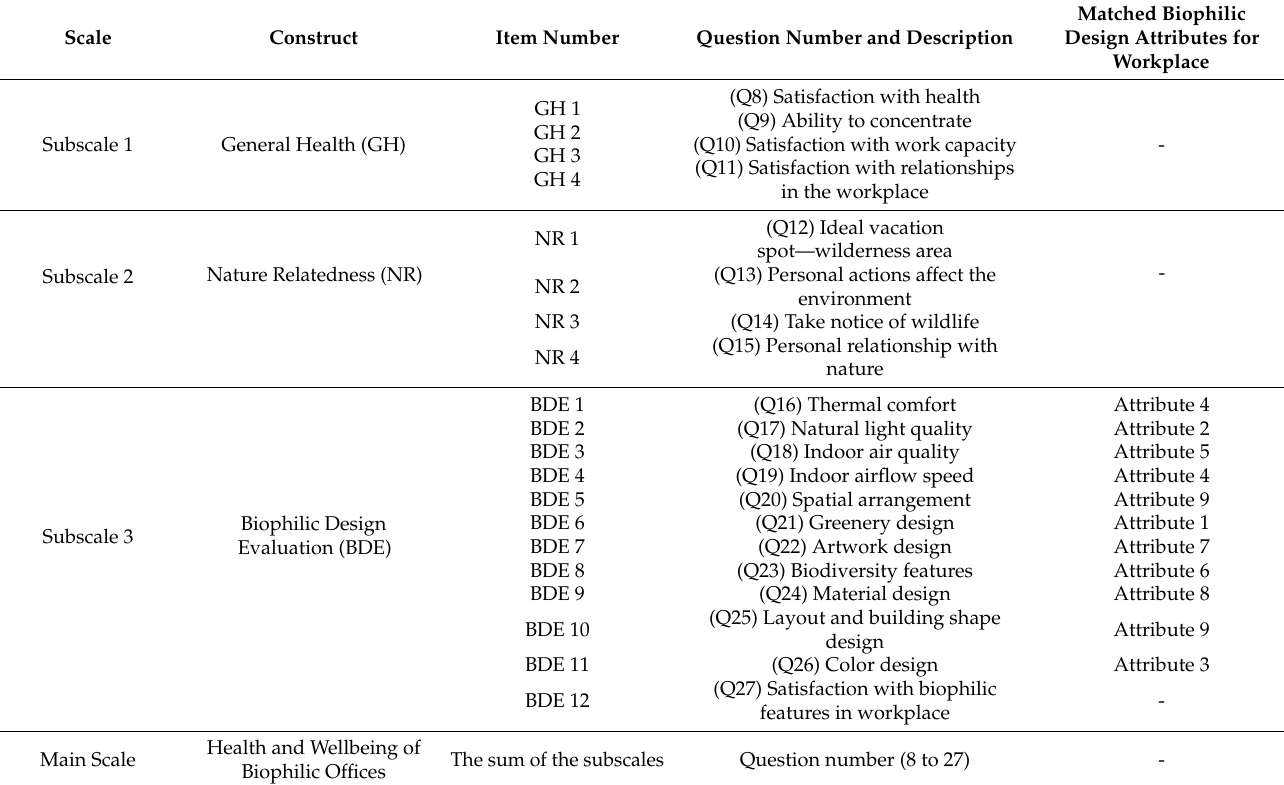
Table 4. Constructs (scales) and assessment items of the